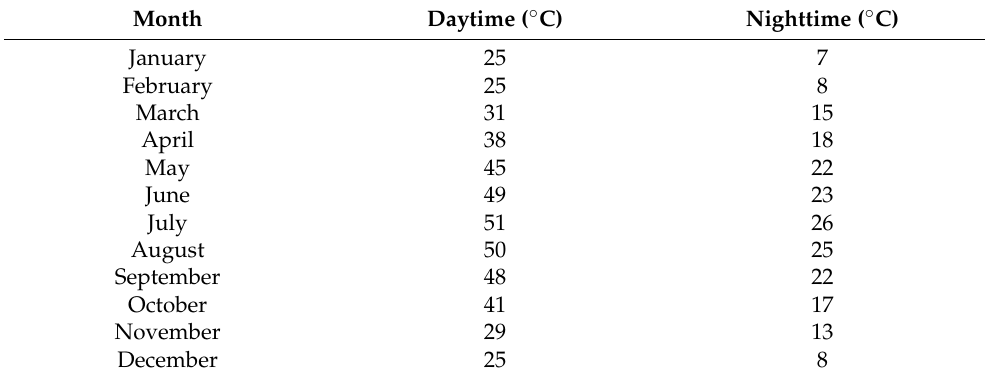
Table 1. Average monthly temperature for Riyadh, Saudi Arabia from 2015–2022 [29].